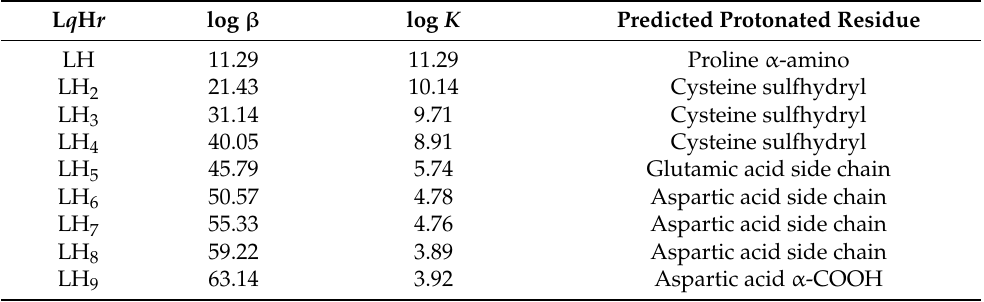
Table 7. Protonation constants (log β ) for the ZnT8 11-residue C-terminal peptide, ionic strength 0.1 M (KNO 3 ), 25 ◦ C. The protonated residues in each species are predicted based on amino acid p K a values.